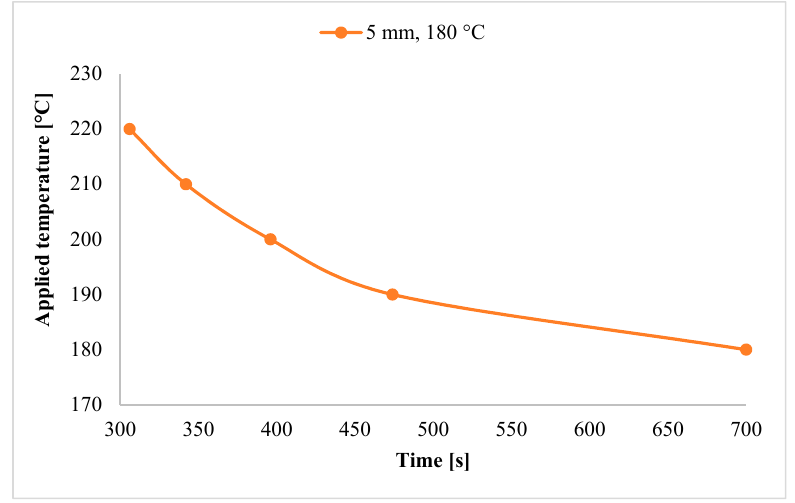
Figure 3. Time to complete a heat transfer of 180 °C, with differing applied temperatures, for a composite thickness of 5 mm.